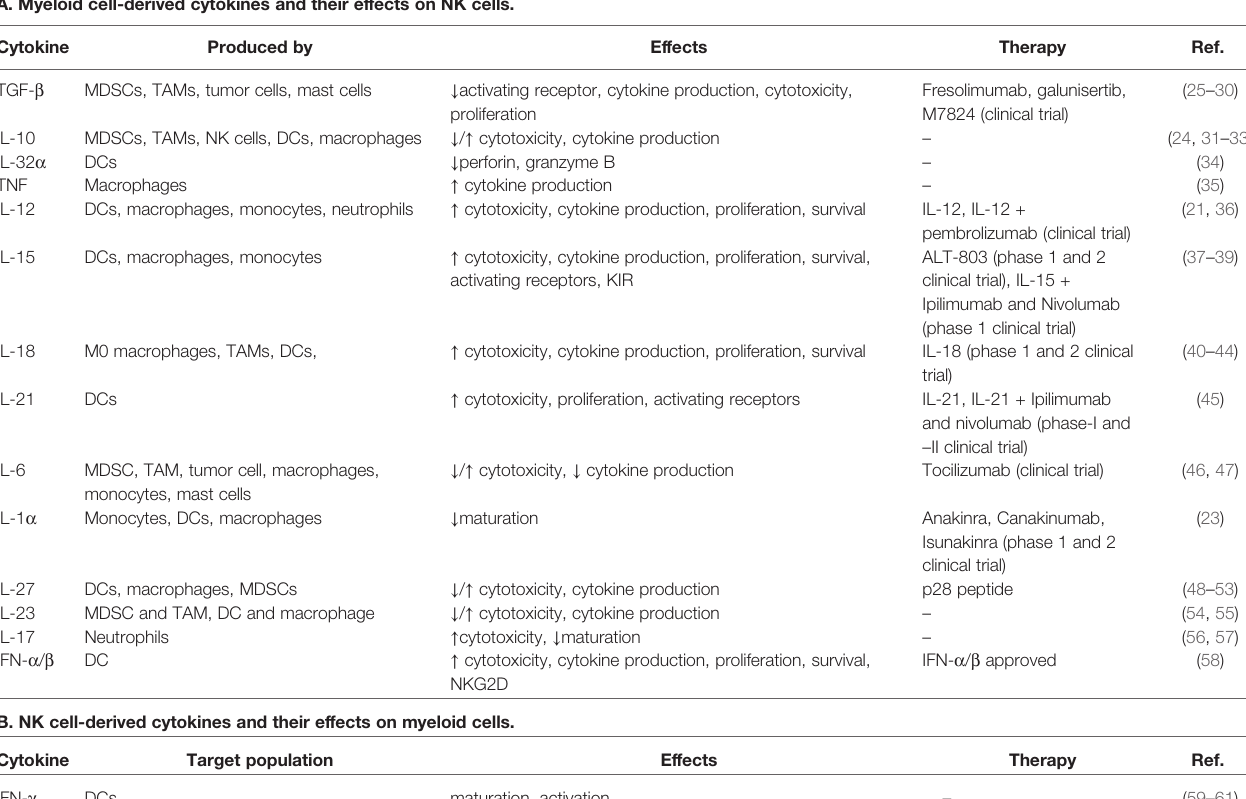
TABLE 1 | Cytokines and chemokines involved in the NK-myeloid cell crosstalk and drugs directed to modulate these